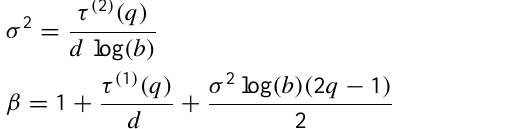
Fig. 5. Spatial Disaggregation model (a) representation of disag- gregation process at various stages, and (b) spatial disaggregation of GCM rain field (horizontal plane) with R 0 =3.6mm at stage s